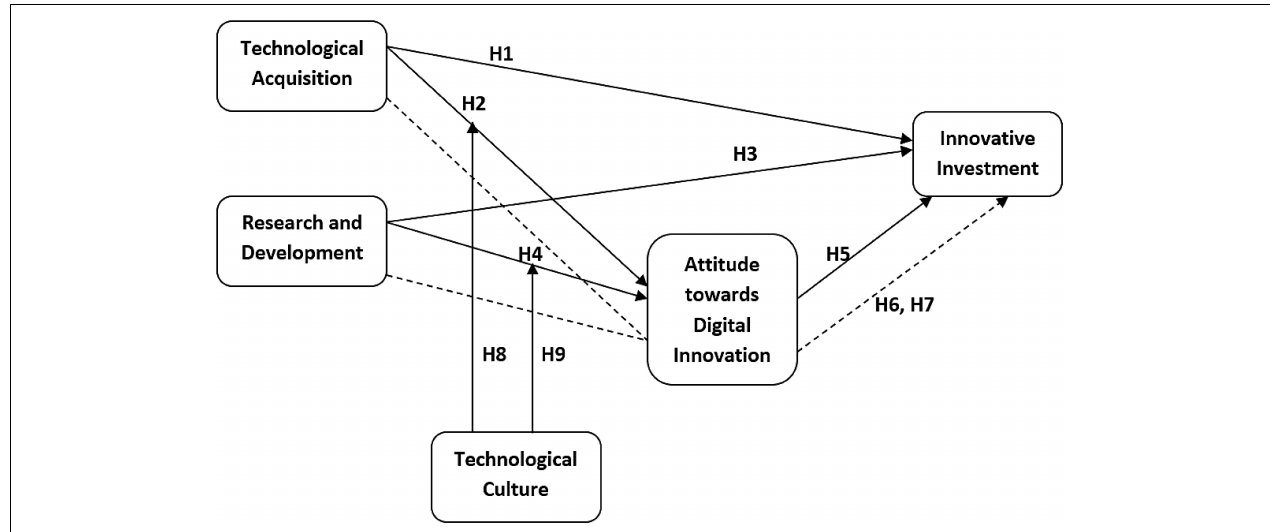
FIGURE 1 | Conceptual